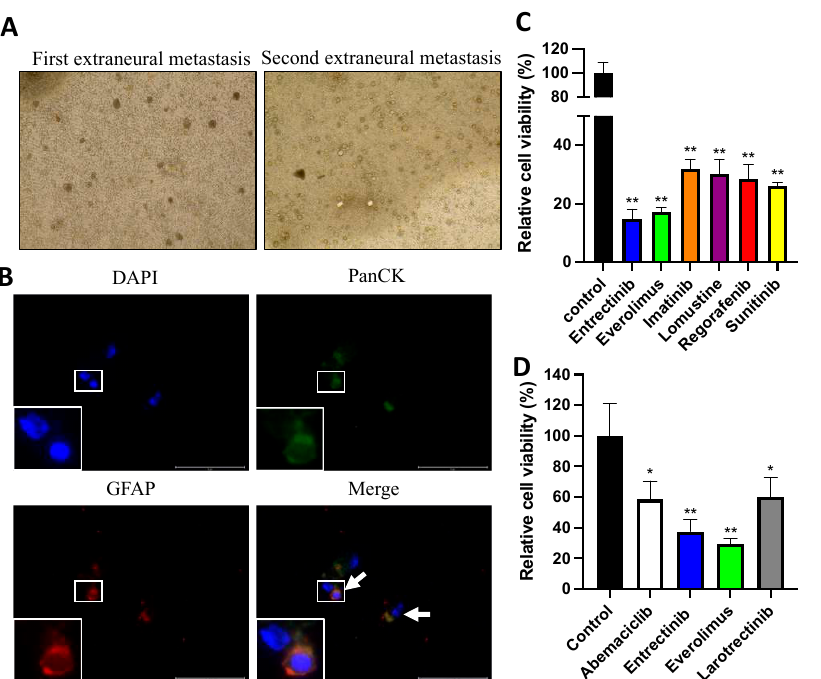
Figure 4. Drug screening of ex vivo circulating tumor cells derived from an ependymoma patient. ( A ) Representative bright-field images of organoids formed from the patient’s blood taken during the first ( left ) and second ( right ) operations of the extraneural metastases. ( B ) Immunofluorescence analysis confirming the circulating tumor cell expression of the markers of tumor cells (white arrows). PanCK: cancer-specific surface marker, GFAP: glial cell marker. Scale Bar: 75 µm. ( C ) Relative cell viability of CTC-derived organoids treated with different concentrations of chemotherapeutic agents from the pe- ripheral blood taken during the first operation of the extraneural metastasis. Entrectinib: 3.13 µM, Everolimus: 0.064 µM, Imatinib: 7.5 µM, Lomustine: 4.3 µM, Regorafenib: 8.08 µM, Sunitinib: 0.181